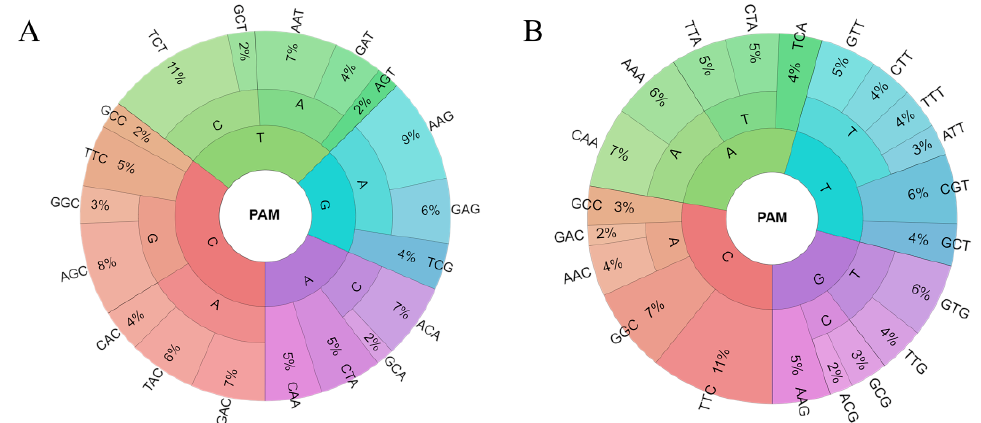
Figure 7. ( A ) The PAM-wheel of 3nt-long statistically overrepresented motifs flanking the theoretical and ( B ) the actual start of the alignment on the targeted strand, in the 3` – 5` direction. The percentages are shown as a function of the associated Z scores [(actual motif counts — sum of all overrepresented motif counts)/sum of all overrepresented motif counts)].